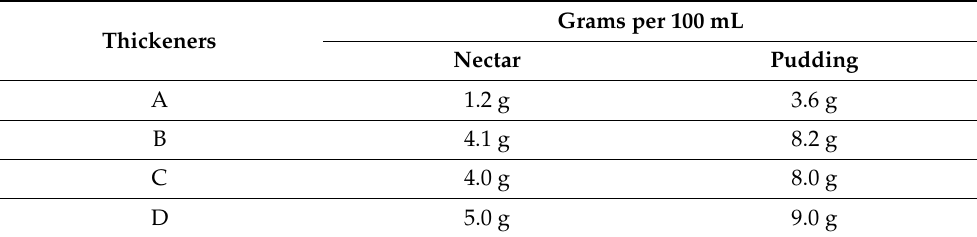
Table 2. Quantity of commercial thickeners